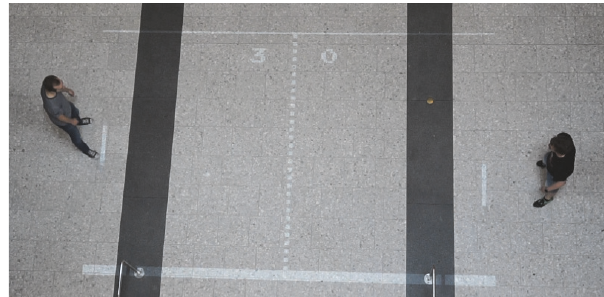
Figure 5: Players interacting with the Save the Turtles!